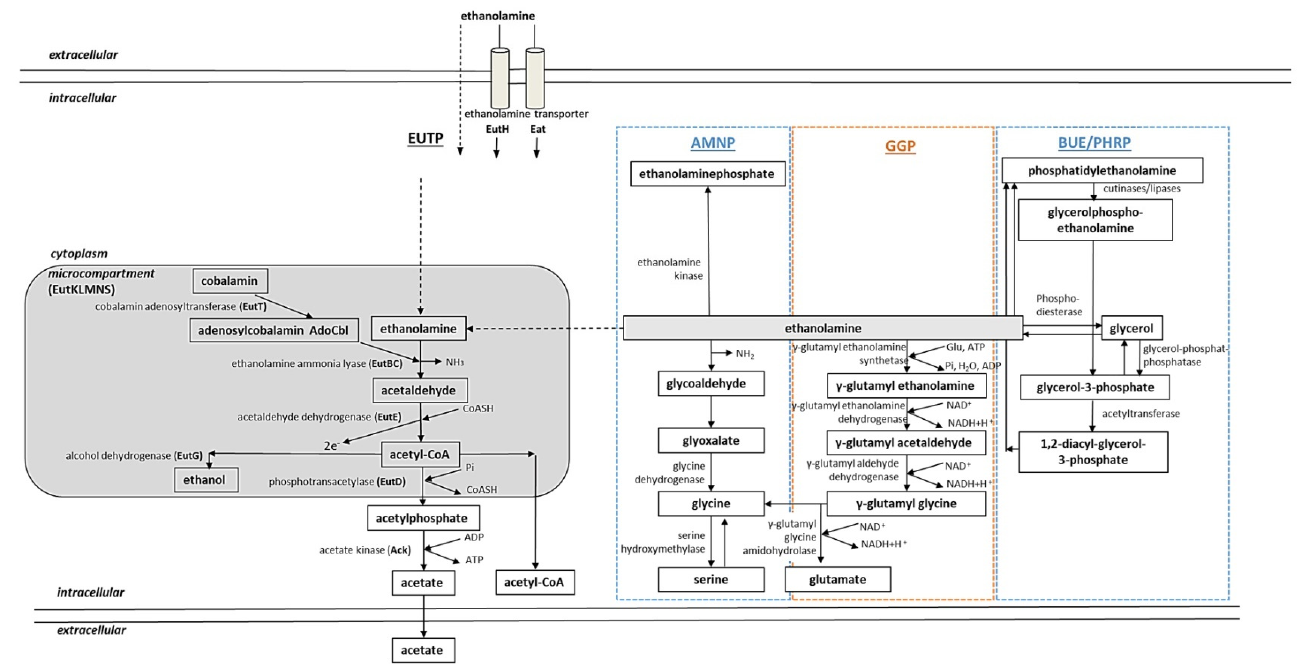
Figure 5. Combined model of bacterial ethanolamine utilization pathways (adapted from [7,114]). Central routes of ethanolamine catabolism with reaction products and involved enzymes, as well as up-to-date polyamine uptake systems known in bacteria, are shown. EUTP: eut -pathway; AMNP: amination pathway; GGP, gamma-glutamylation pathway; BUE: biosynthetic utilization of ethanolamine; PHRP: polar head recycling pathway. Dashed arrows represent diffusion. Gray, rounded rectangle represents the bacterial microcompartment. Pathways in black: E. coli and S. typhimurium ; dashed blue box: Mycobacterium sp. and M. tuberculosis ; dashed orange box: C. salexigens and S. coelicolor [7,234,236,237,243,249–251,254,264].